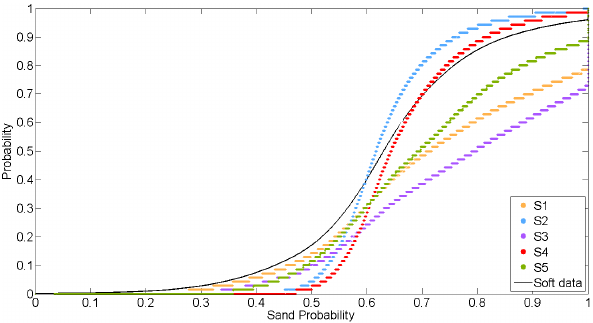
Figure 14. Black line indicates the CDF of the sand probability Figure 14: Black line indicates the cumulative distribution function (CDF) of the sand 2 from soft data. Point plots are Q–Q plots of the average of realiza- probability from soft data. Point plots are Q-Q plot of the average of realizations from each 3 tions from each scenario against soft scenario against soft data. 4